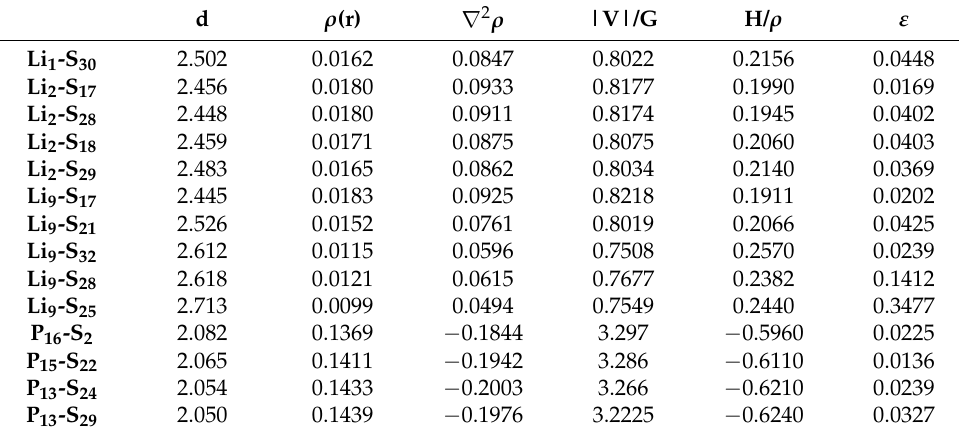
Table 2. Value of several local quantities at the bond critical points in Pn2 1 a β -Li 3 PS 4 structure: the bond distance (Å), the electron charge density ( ρ (r)) (Å − 3 ), the Laplacian of the density ( ∇ 2 ρ ) (Å − 5 ), the ratio between the potential energy density and the kinetic density (|V|/G), the bond degree (H/ ρ ) (a.u.) (i.e., the ratio between the total energy density and electron density), and the ellipticity ε